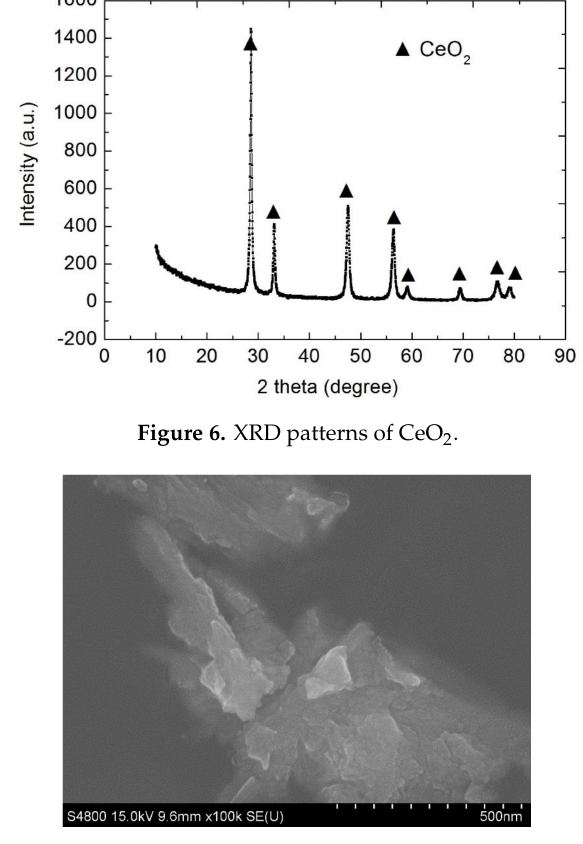
Figure 7. SEM image of CeO 2 nanoparticles.